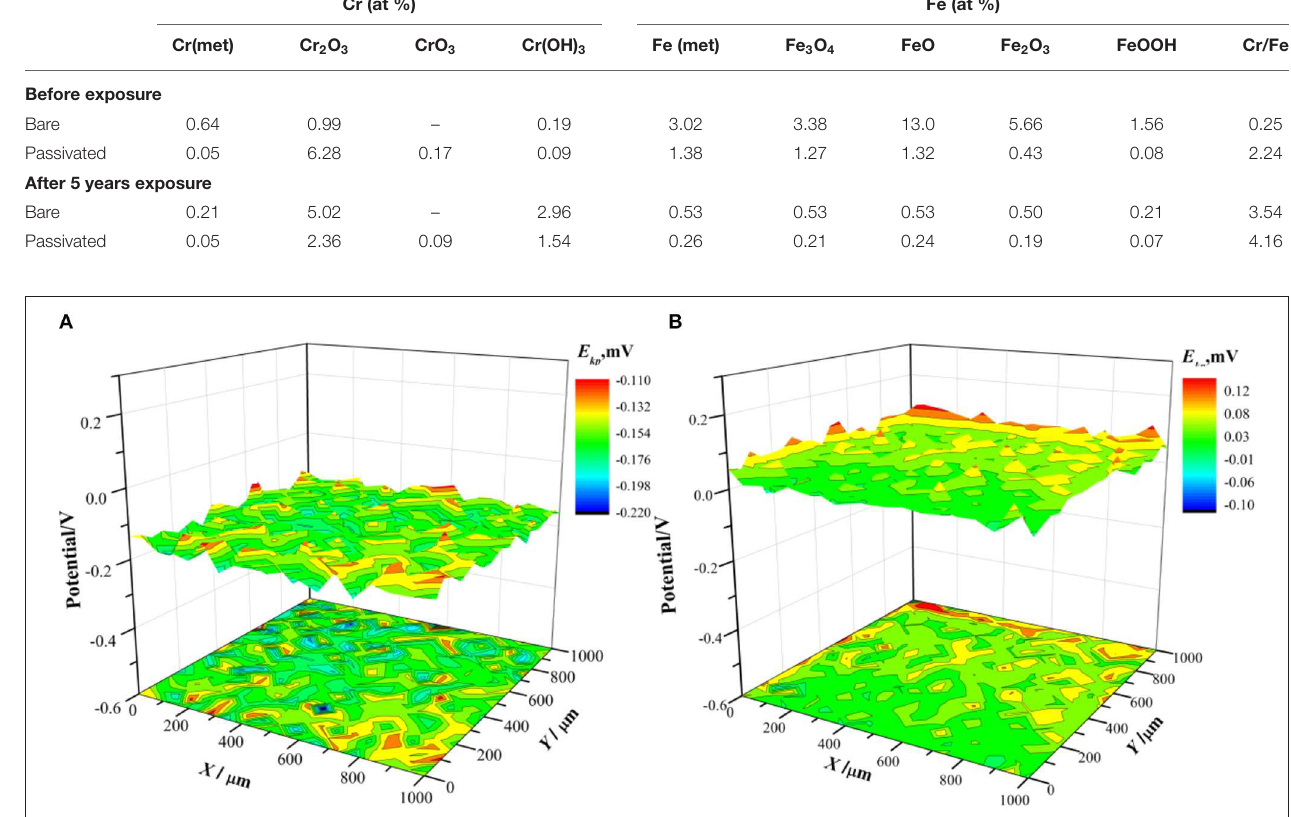
TABLE 3 | The fraction of Cr and Fe in the surface of the PH13-8 Mo stainless steel. Cr (at %)